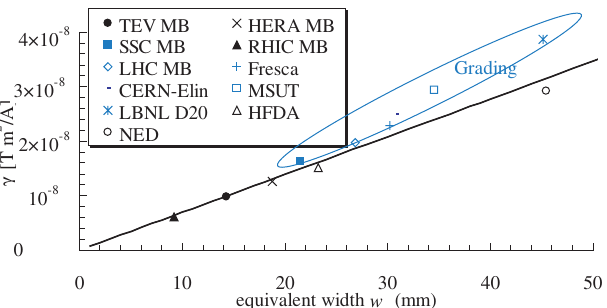
FIG. 13. (Color) Parameter (cid:6) (central field per unit of current density) for 11 accelerator dipoles without iron (markers) and results for a 0 (cid:12) –48 (cid:12) , 60 (cid:12) –72 (cid:12) sector (solid line) vs equivalent width defined in Eq.